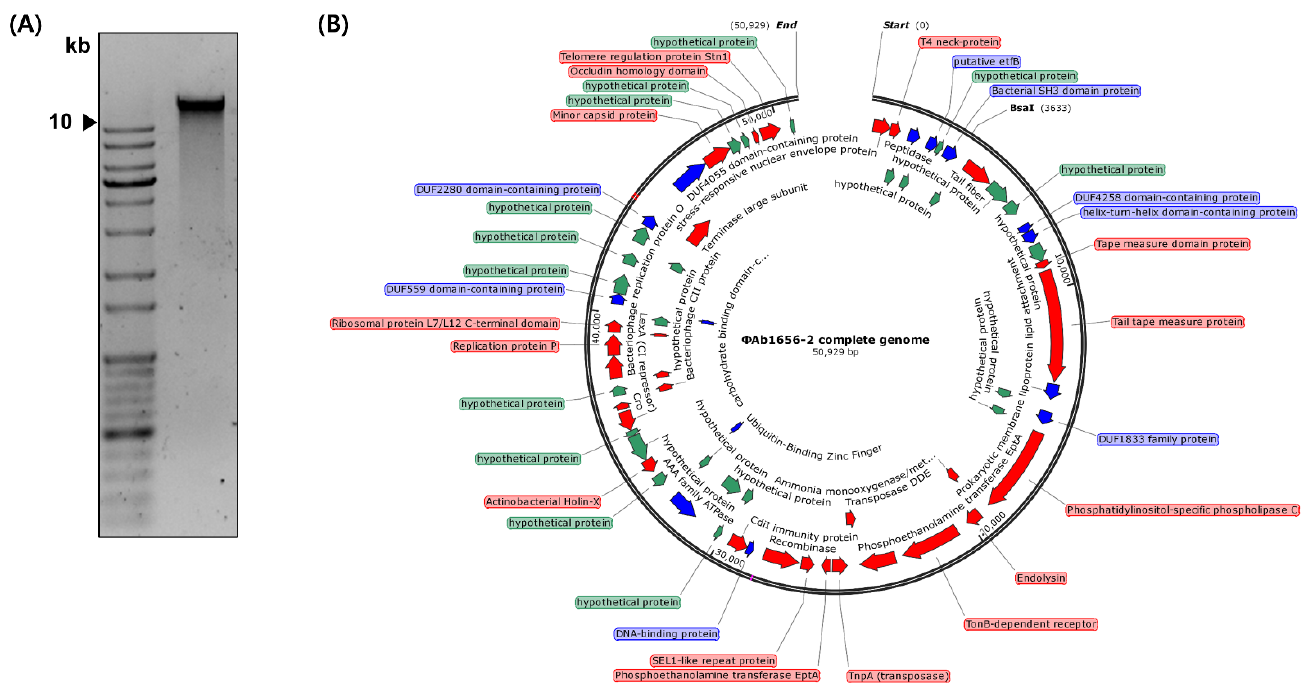
Figure 3. Complete genome of Φ Ab1656-2. ( A ) Isolated genomic DNA of Φ Ab1656-2 loaded on 1% agarose gel. The black arrowhead indicates 10 kb. ( B ) Genome map of Φ Ab1656-2. The genome size of Φ Ab1656-2 was identified as 50.9 kb, and 68 putative ORFs were predicted. Green represents predicted hypothetical proteins, blue represents putative functional proteins, and red represents phage-related proteins.